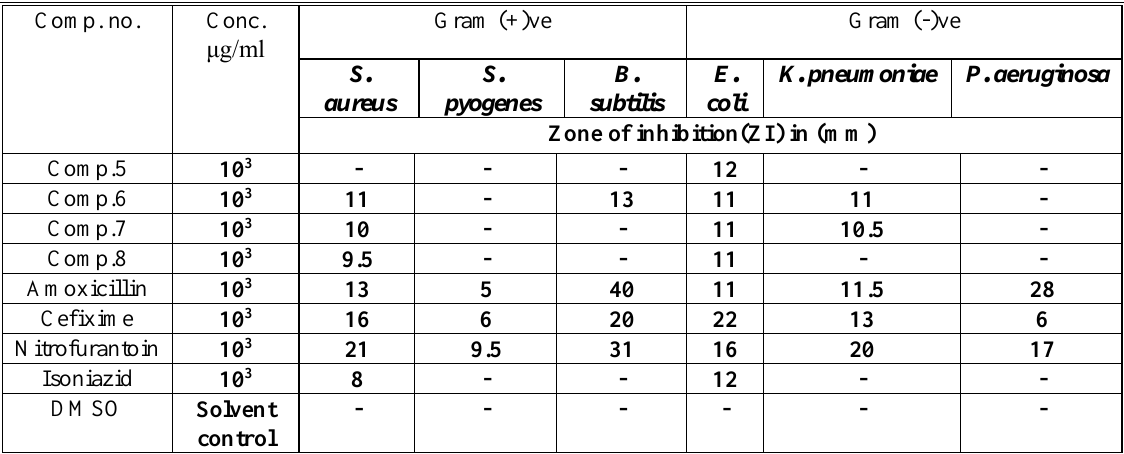
Table 1.The antibacterial activities of synthesized compounds. Comp. no.